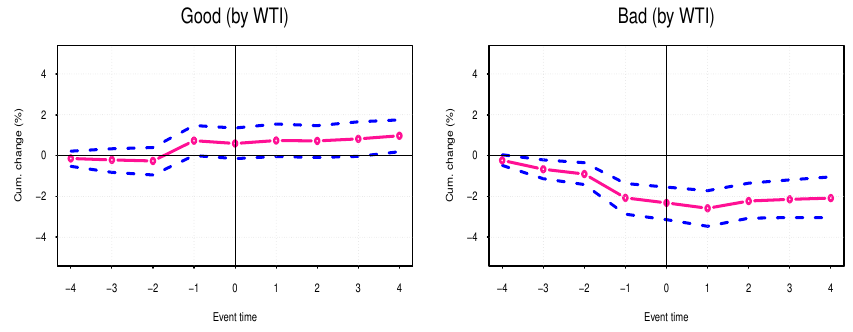
Figure 4. Extreme event on WTI oil and response of Solar.